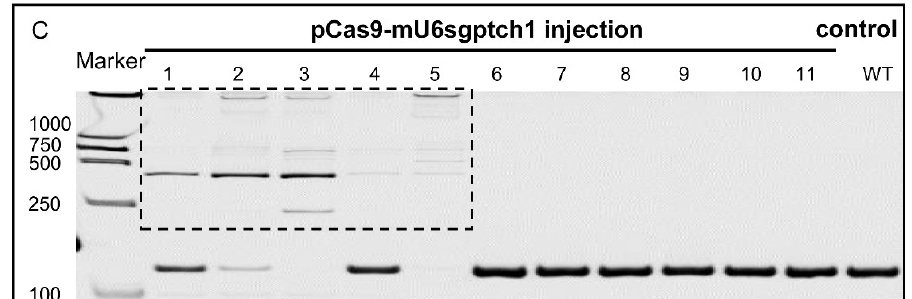
Figure 5. pCas9-mU6sgRNA mediated the exogenous and endogenous gene editing in medaka in vivo by one-cell embryo microinjection. ( A – B″ ) Microscopy images of medaka embryos injected with pCas9-mU6sgNtsf1 and the reporter vector pGNtsf1 ( A – A″ ) or injected with pGNtsf1 alone ( B – B″ ) 24 h after injection. Scale bars, 100 μm. ( C ) HMA of DNA templates extracted from embryos injected with pCas9-mU6sgptch1. Genomic DNA of each embryo was extracted separately. Boxed area indicates the heteroduplex or homoduplex DNA bands in amplicons from pCas9-mU6sgptch1 injected medaka embryos.